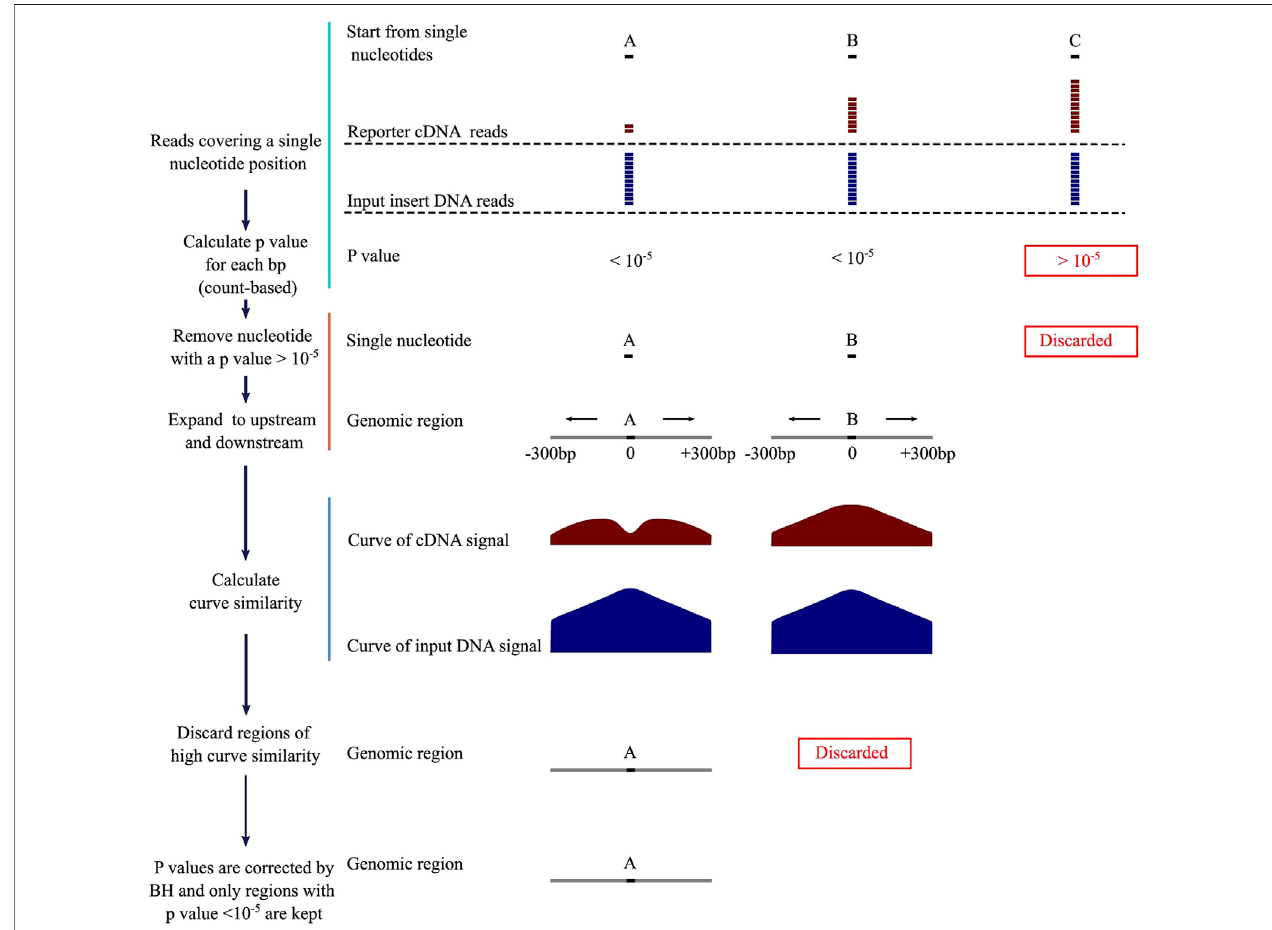
FIGURE 1 | Negative regulatory element identi fi cation pipeline. BH, Benjamini – Hochberg correction.